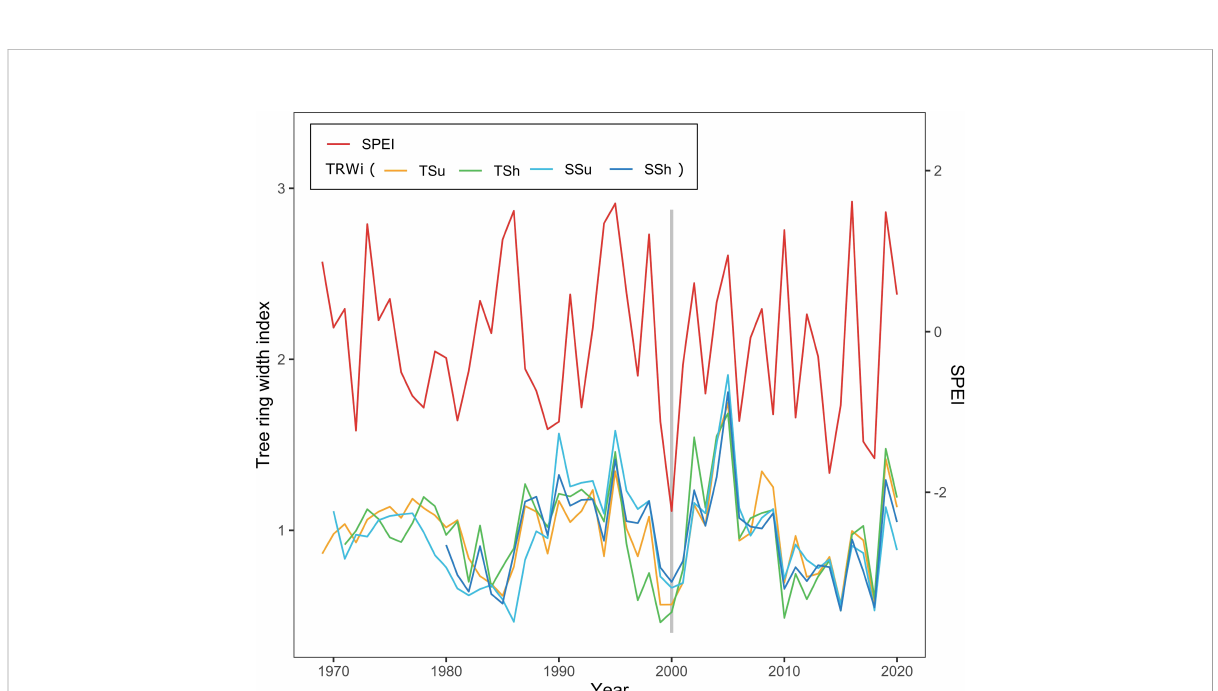
FIGURE 3 Standard chronologies (STDs) of the tree ring width index (TRWi) among all plots and Standardized Precipitation Evapotranspiration Index (SPEI) distribution show the drought event. The bar chart denotes the year of the drought event on all plots (2000).